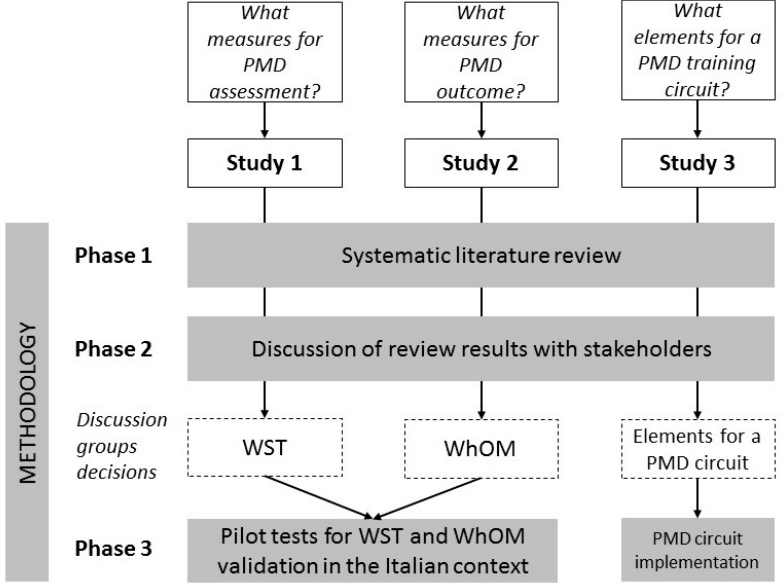
Figure 2. Diagram illustrating the three-phase research approach used for each of the three studies described.